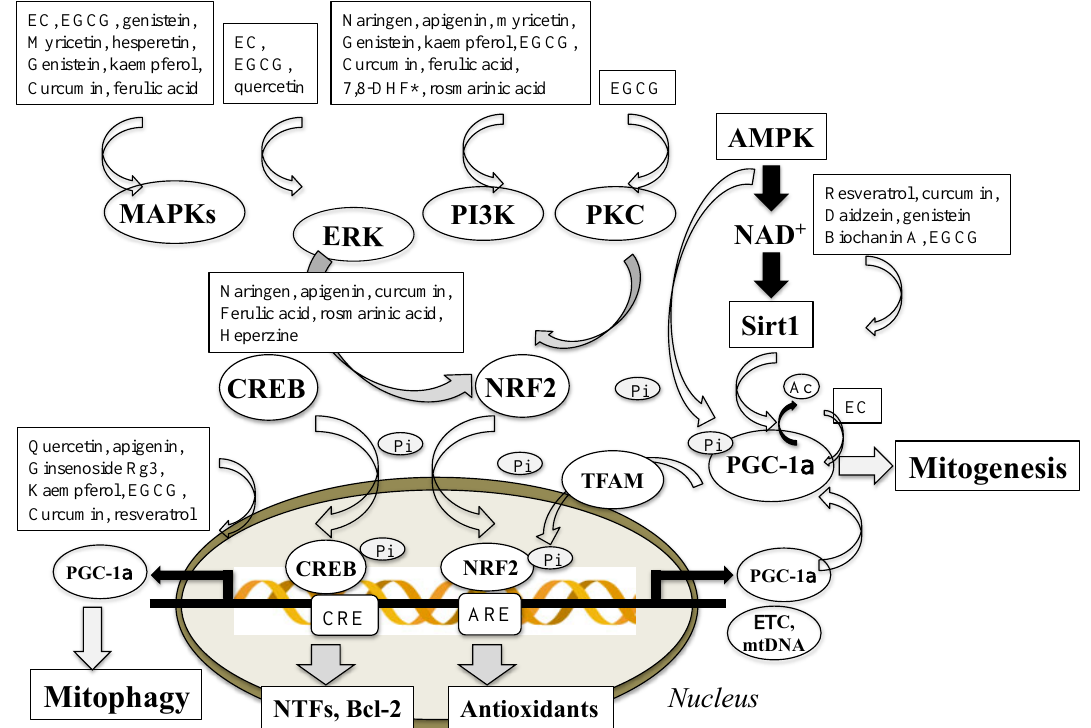
Figure 6. E ff ects of polyphenols on cellular signal transduction to activate mitogenesis. Polyphenols directly activate peroxisome proliferation-activated receptor γ coactivator 1 α (PGC-1 α ) by deacetylation or phosphorylation through AMP-activated protein kinas (AMPK)-situin-1 (Sirt1) pathway. Polyphenols also enhance PGC-1 α expression by mitochondrial transcription factor A (TFAM) / CREB signal pathway and protein kinases / Nrf (nuclear respiratory factor-1) / ARE (antioxidant responsive element) pathway. In addition, polyphenols activate other protein kinases and transcription factors and increase the expression of genes regulating mitochondrial function and homeostasis. * 7,8-dihydroxyflavone. White and black arrows indicate promoting and inhibiting e ff ects,